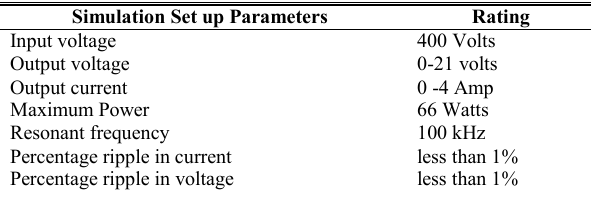
Table 1. Simulation Parameters of LLC Resonant Converter